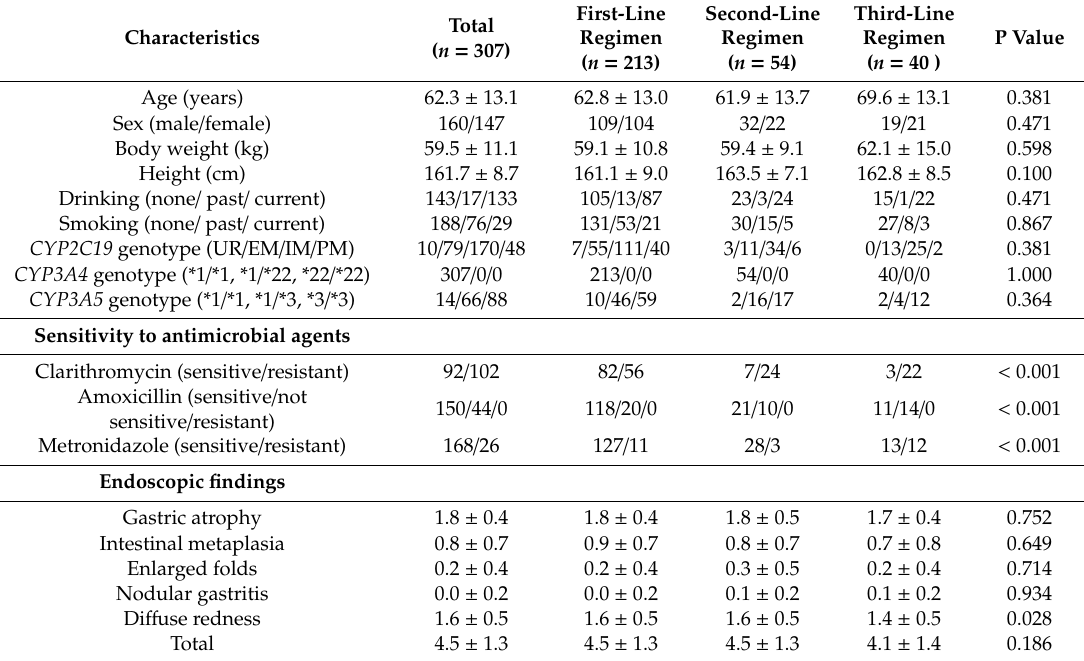
Table 1. Characteristics of patients positive for Helicobacter